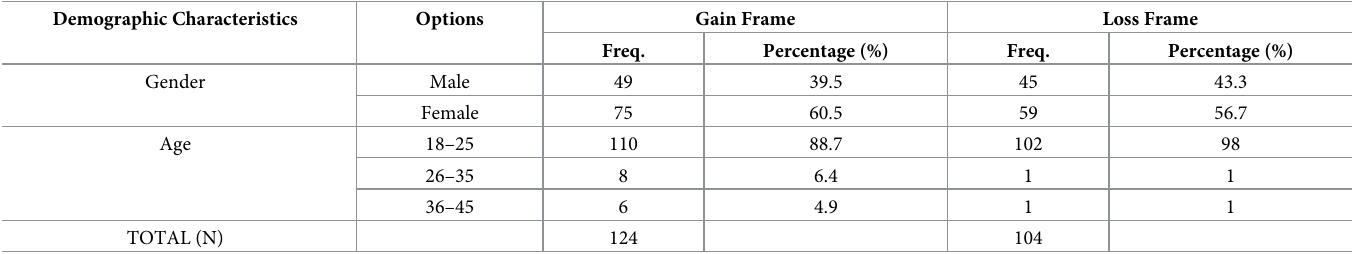
Table 3. Respondents’ demographic